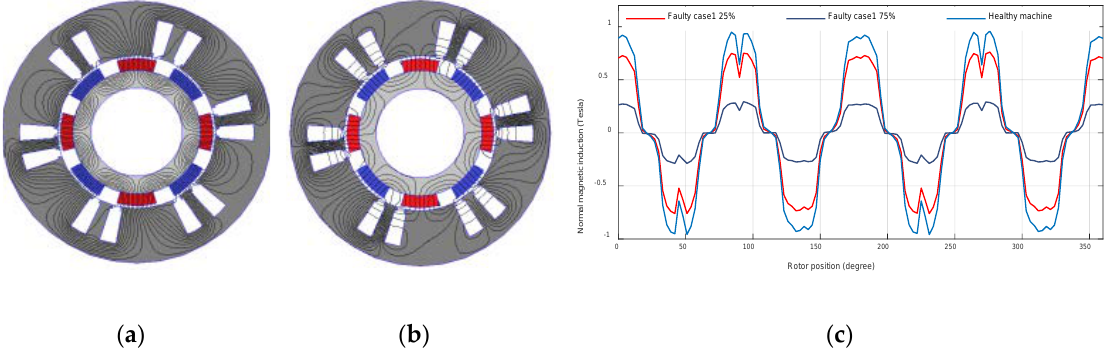
Figure 6. Faulty case 1: ( a ) Magnetic field under 25%; ( b ) magnetic field under 75%; ( c ) airgap magnetic flux density.